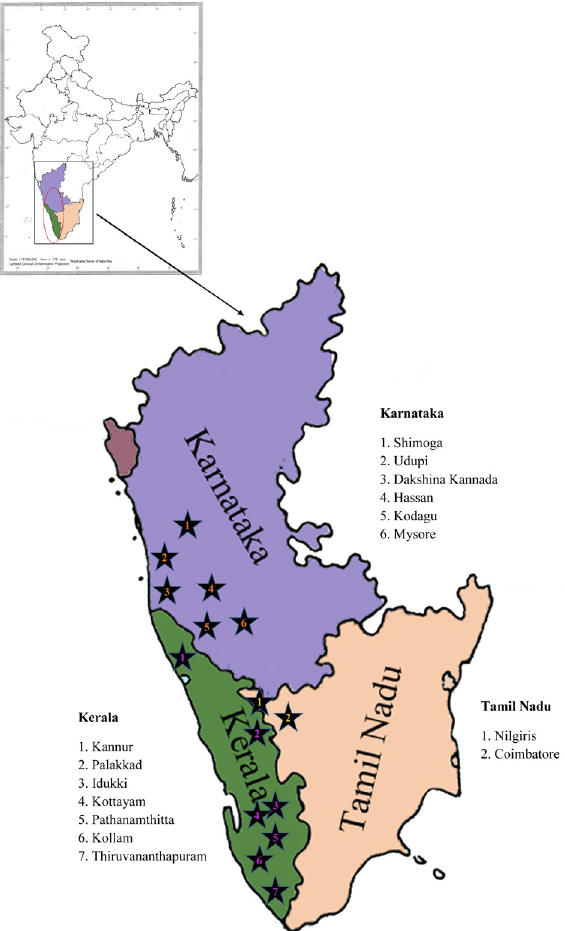
Image 7. Distribution of Bauhinia phoenicea